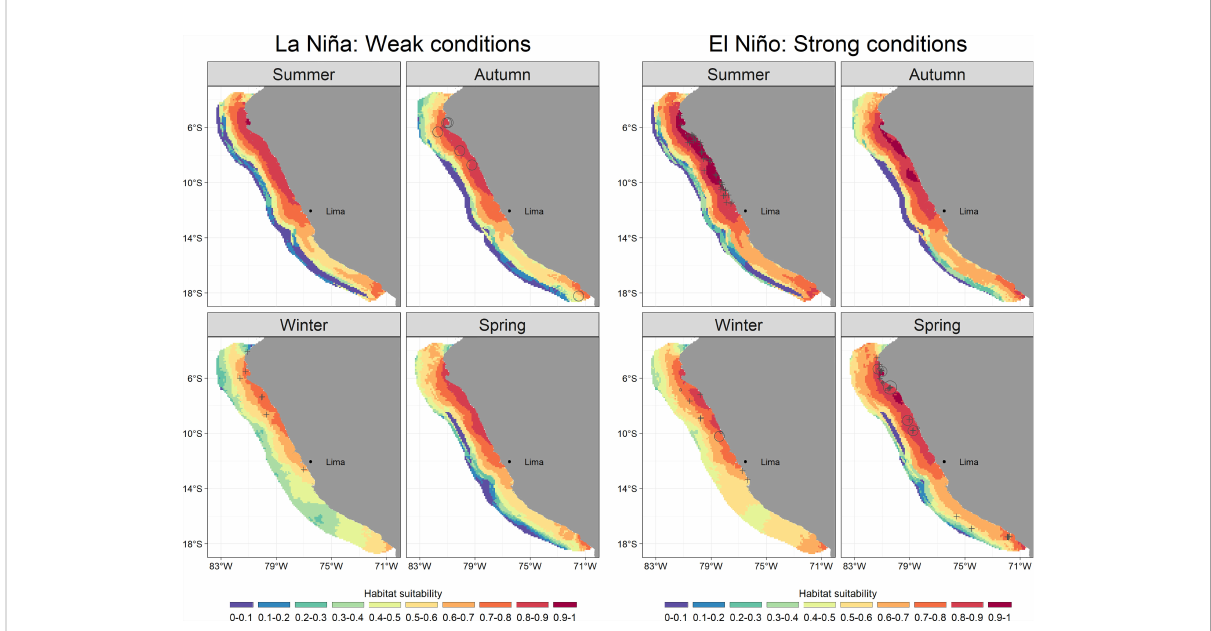
FIGURE 5 Predicted values of common dolphin ( Delphinus delphis spp.) habitat suitability for the geographical space during La Niña and El Niño conditions. Empty circle sizes represent the observed group counts in each sample unit (i.e., transect). Crosses represent validation data, not included as data in the